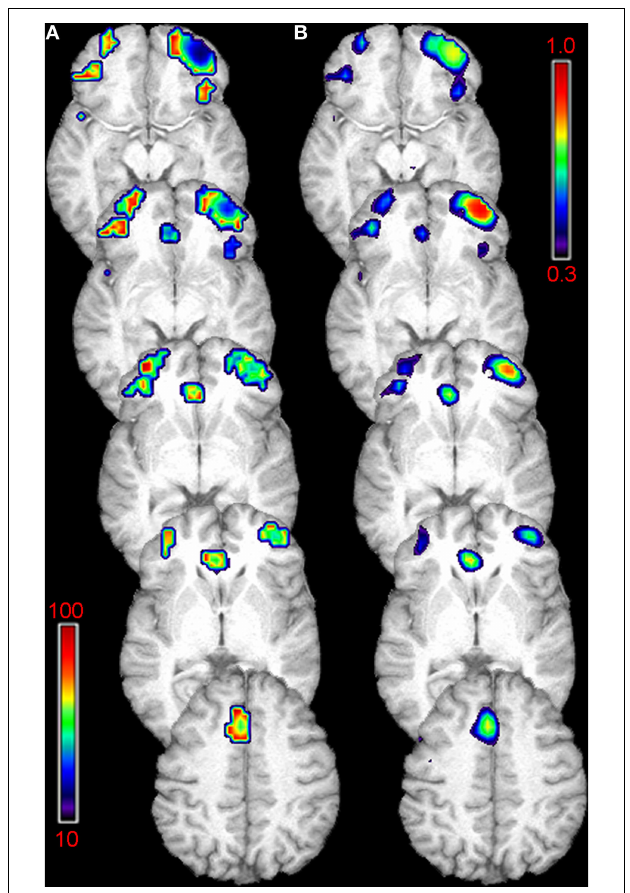
FIGURE 3 | Sample-size and power estimates. Exploratory analyses based on observed changes in CBF for treatment versus controls yielded voxel-wise estimates of the number of subjects required in each group to detect a signifi cant fi nding with 80% power (A) , and the power to detect signifi cant changes, given 50 subjects in each group (B) . Future studies that add several subjects to each group could reveal more extensive areas of CBF increase, including bilateral IFC, rostral anterior cingulate cortex (ACC), and medial frontal cortex (MFC) ( A – voxel intensity represents number of subjects required for signifi cant fi nding, p < 0.05, FWE corrected). The statistical power to detect training-induced effects, with 50 subjects per group, would be near 70% for right IFC, rostral ACC, and MFC ( B – voxel intensity indicates power level with n =